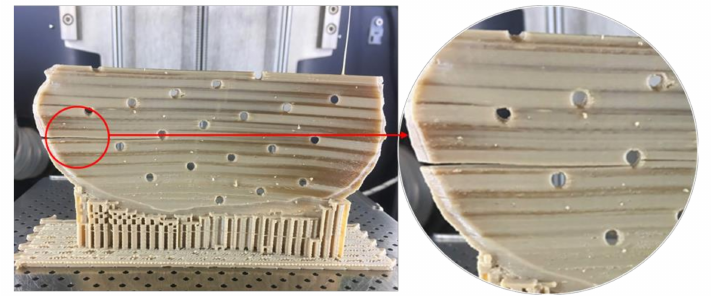
Figure 11. Structural failure in the PEEK cranial implant during the FFF 3D printing